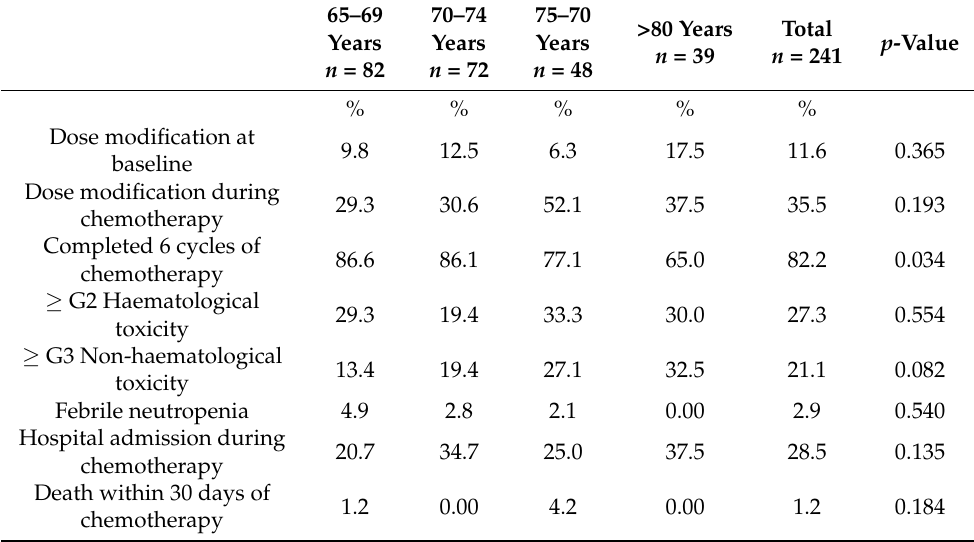
Table 3. Treatment